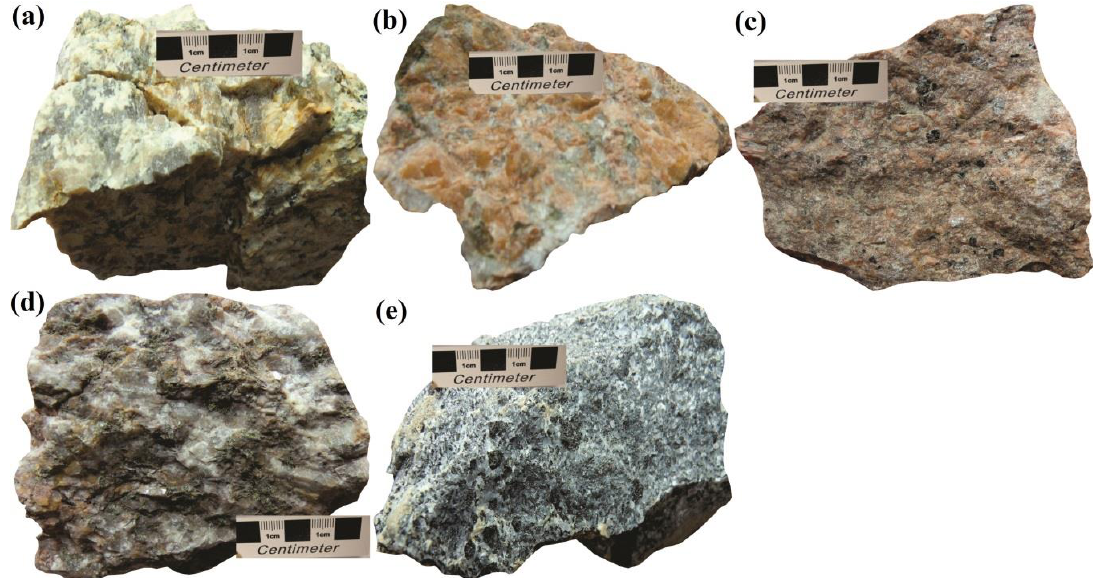
Figure 2. Photographs of the granitoid samples used for this study ( a ) fresh and weathered color of the Beidao granite (TDG-1), ( b ) orange variety of the Beidao granite (TDG-4), ( c ) porphyritic texture of the Caochuanpu granite (TCG-2), ( d ) pink variety of very coarse-grained Yuanlongzhen granite (TYG-1), and ( e ) Roche type rock (RTR-1) containing quartz and tourmaline crystals.